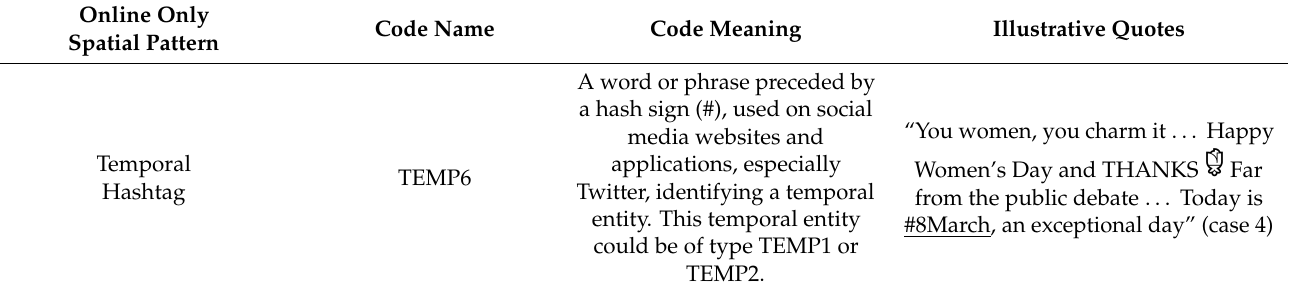
Table A7. Temporal Patterns in SP data online only.